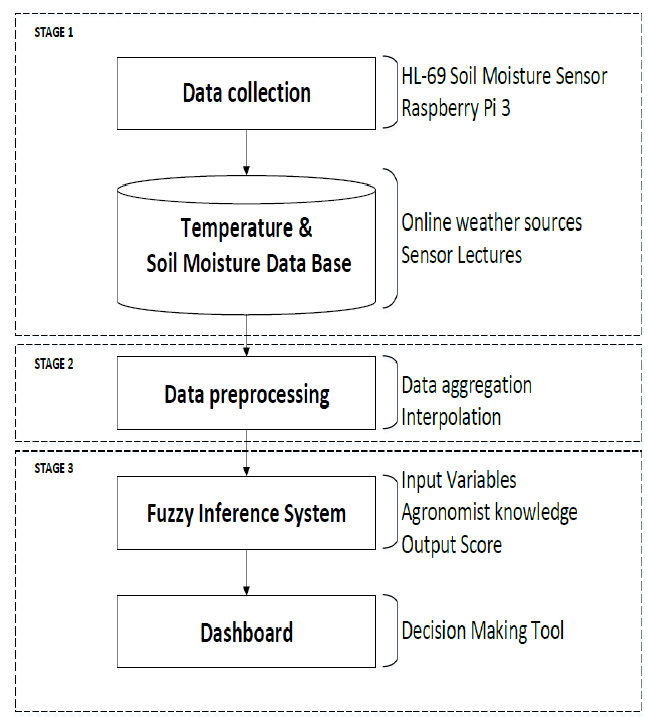
Figure 1. Proposed